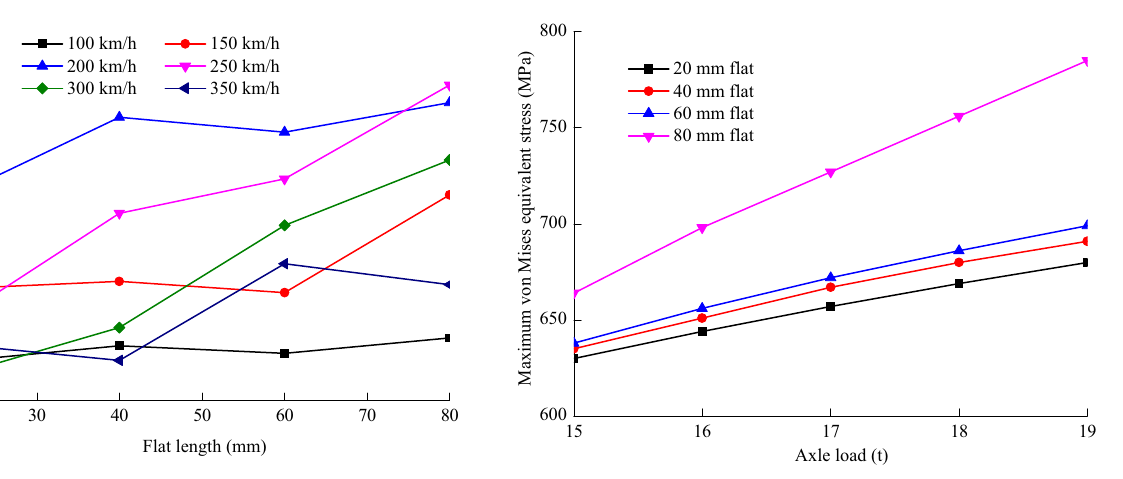
Fig. 13 Maximum von Mises equivalent stress versus